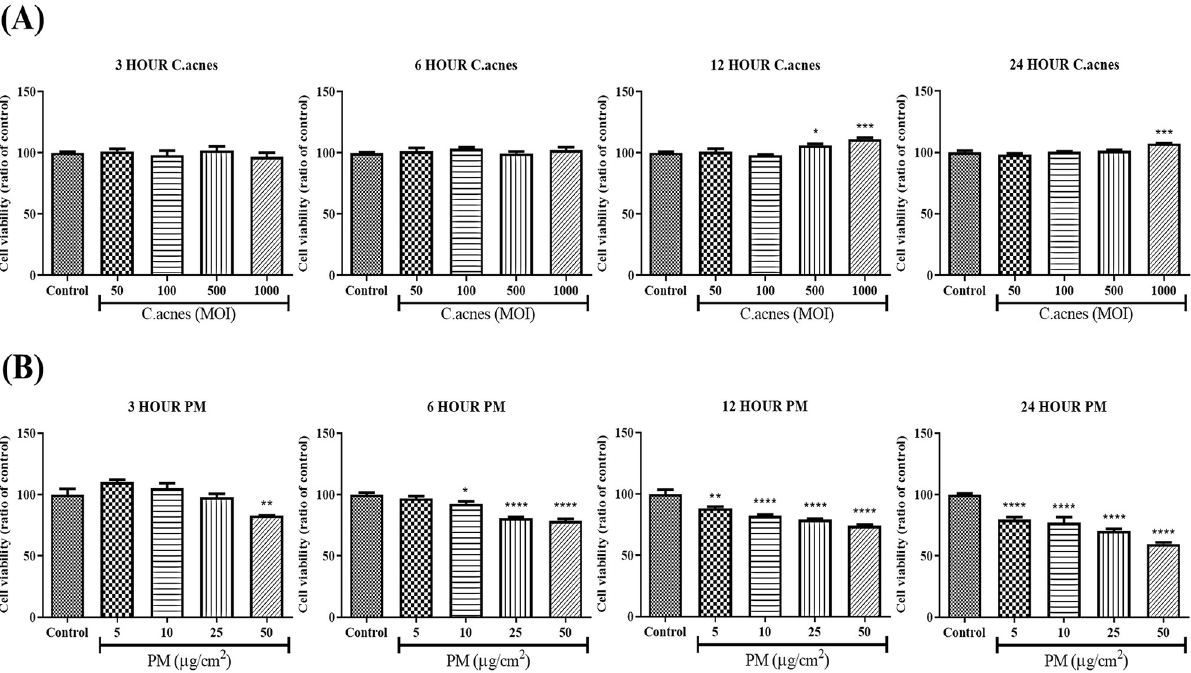
Fig 1. Effect of PM and C . acnes on the viability of HEKn cells. Cytotoxicity of heat-killed C . acnes and PM on HEKn cells determined by the MTT assay. (A) HEKn cells were treated with several concentrations of (A) heat-killed C . acnes (50–1000 MOI) and (B) PM (5–50 μ g/cm 2 ) for 3–24 h. Data are shown as mean + standard error of the mean (SEM). Statistical significance was determined by repeated measures ANOVA, post hoc Bonferroni correction, comparing to control ( � p < 0.05, �� p < 0.01, ��� p < 0.001, ���� p < 0.0001).